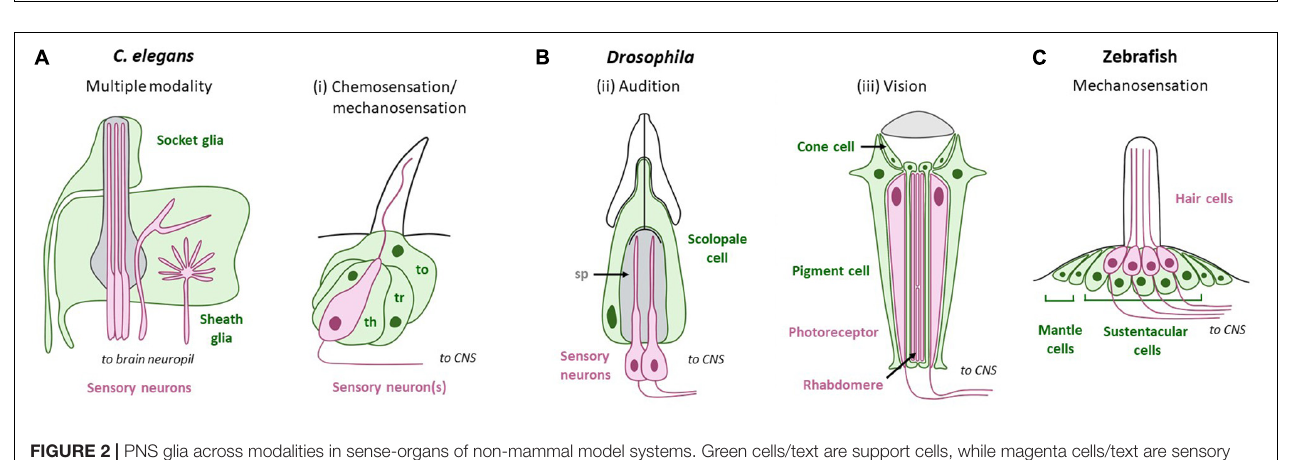
FIGURE 2 | PNS glia across modalities in sense-organs of non-mammal model systems. Green cells/text are support cells, while magenta cells/text are sensory cells. (A) C. elegans sense-organs comprise socket and sheath glia that ensheath sensory NREs. (B) Support cells in Drosophila . (i) Chemosensation/mechanosensation: Thecogen (sheath glia; th), trichogen (shaft glia; tr), and tormogen (socket glia; to) associate with neurons in sensory hairs called sensilla. (ii) Audition: Sensory neurons in Johnston’s organ are surrounded by the scolopale space (sp), which is regulated by glia-like scolopale cells. (iii) Vision: Drosophila photoreceptor cells are surrounded by two types of glia: pigment cells and cone cells. (C) Zebrafish hair cells in the lateral line are organized into neuromasts. Each neuromast houses hair cells intermingled with sustentacular cells at the center, and mantle cells at the periphery. Adapted using